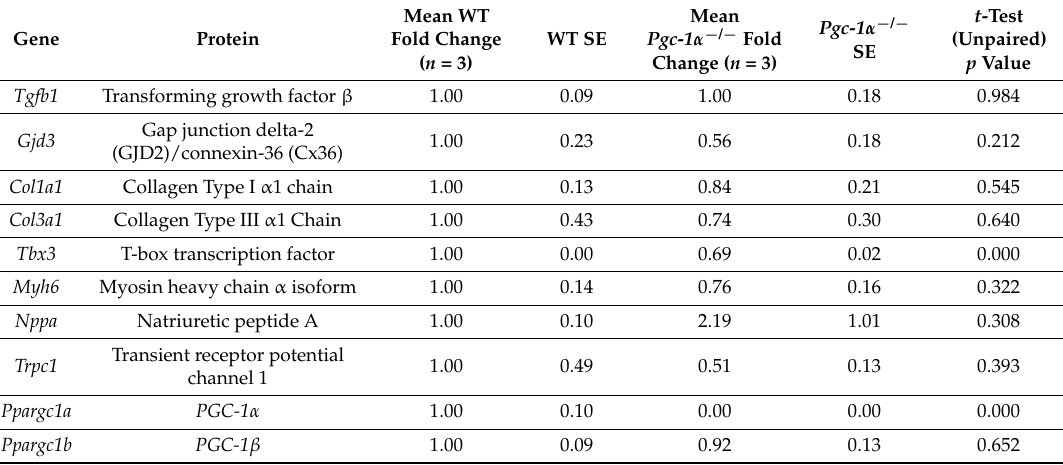
Table 8. Other mean gene fold changes in Pgc-1 α − / − compared to WT